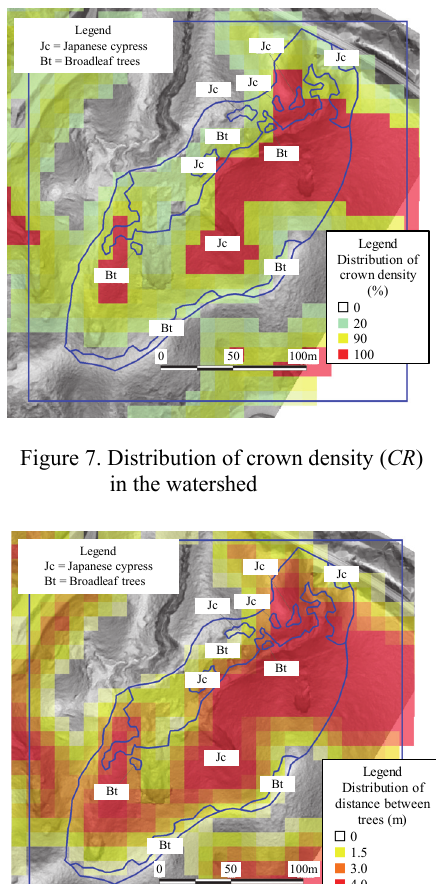
Figure 5. Tree height ( H ) in the watershed